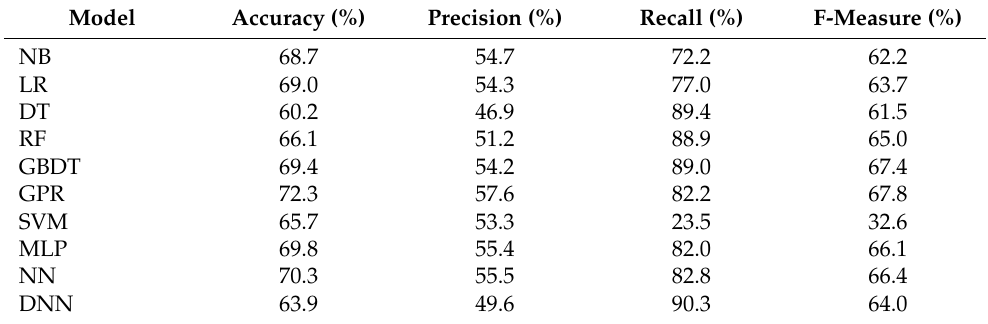
Table 12. Comparison of machine learning models based on analysis with six indoor thermal factors.